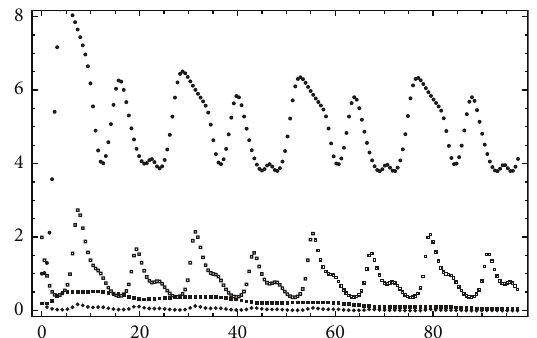
= 0 , and 𝑥 (𝜃) = cos (𝜋𝜃/10) . 0 0